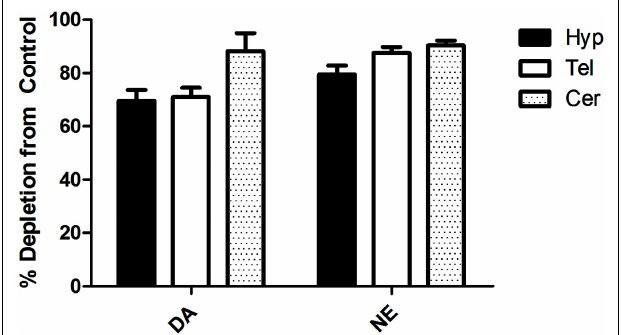
FIGURE 1 | Percent depletion of dopamine (DA) and norepinephrine (NE) in different brain tissues relative to saline-injected control 6d post-injection with MPTP and 1d post-injection with α MPT ( p < 0.01 in all cases, relative to control). Tel,Telencephalon; Hyp, Hypothalamus; Cer,